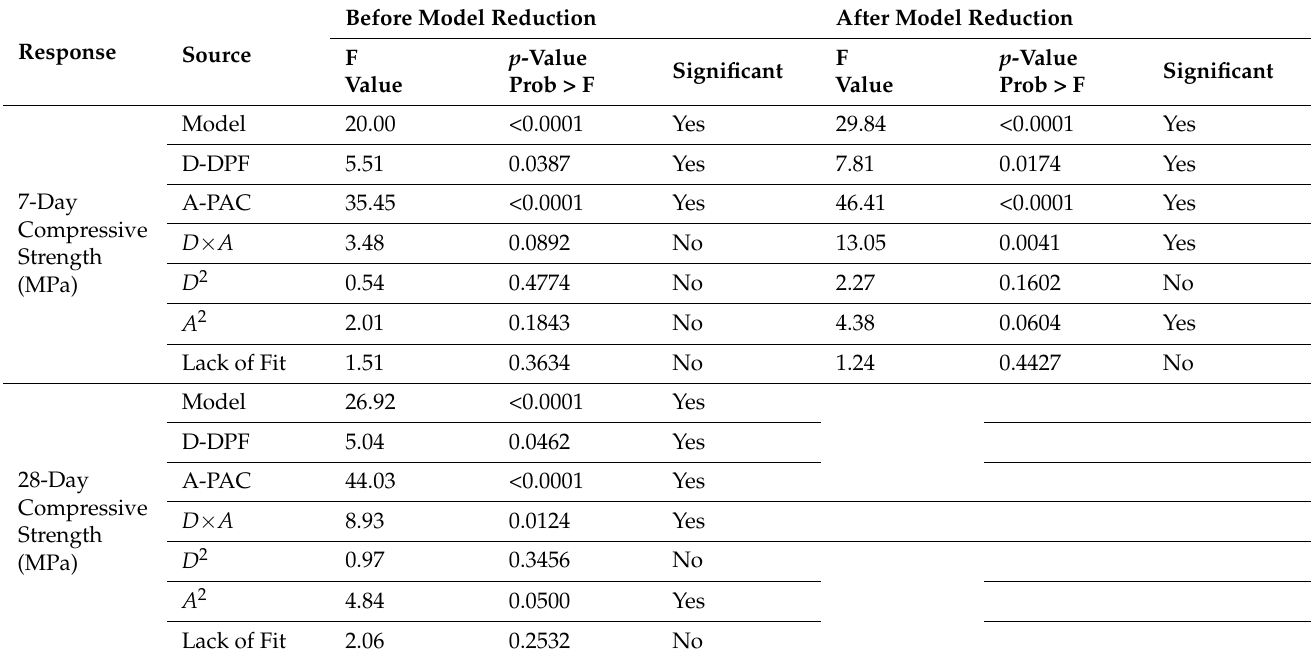
Table 6. Compressive Strengths Models